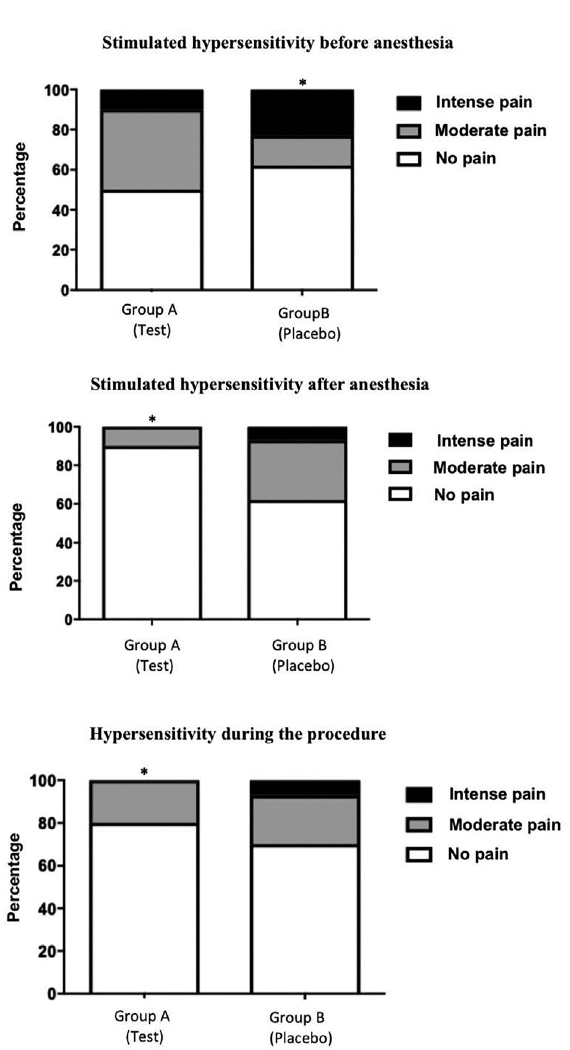
Figure 2- Statistical analysis of hypersensitivity in patients who received analgesic (A) or placebo